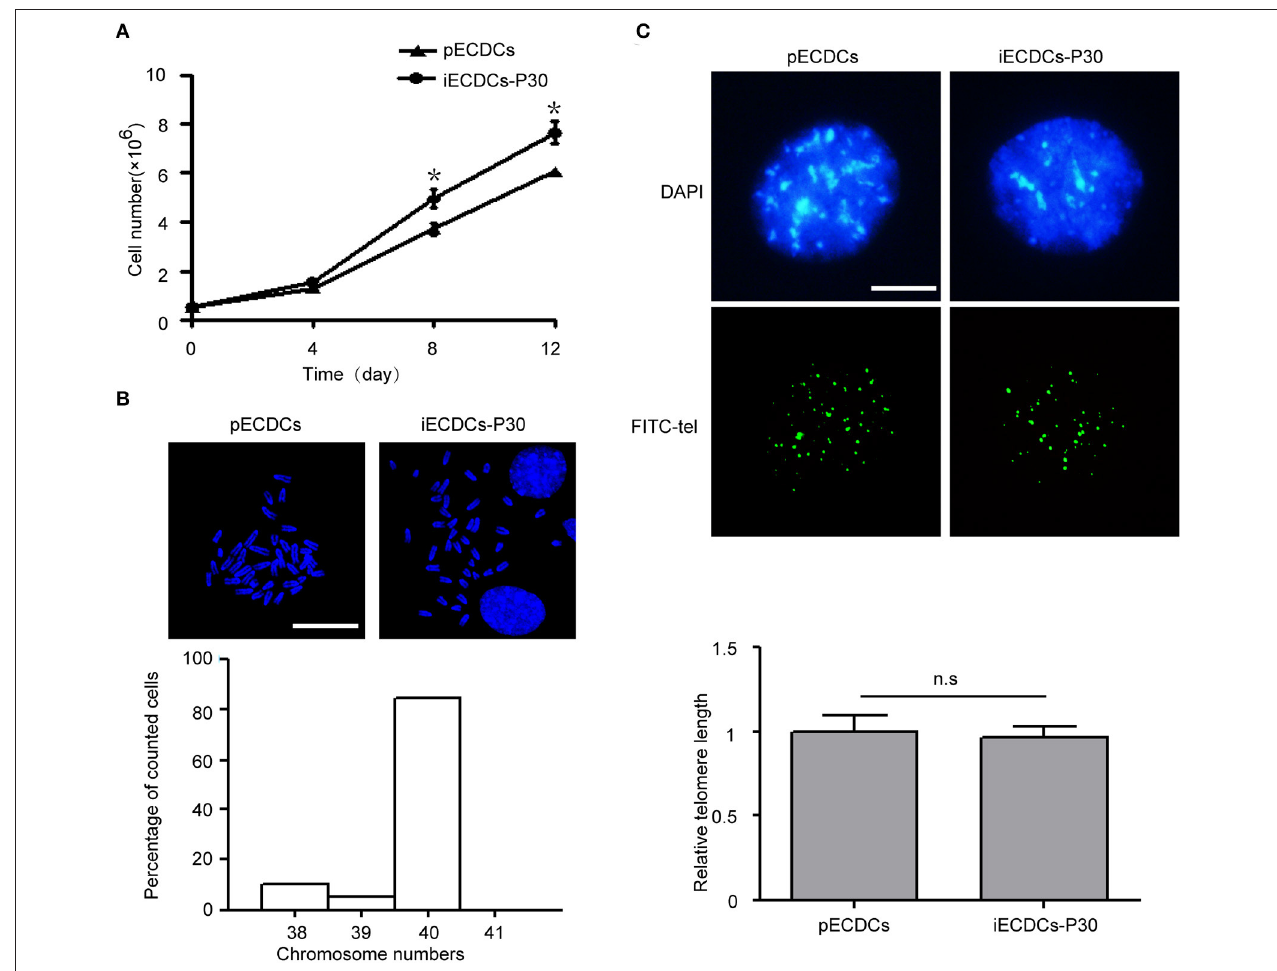
FIGURE 2 | Establishment of mouse immortalized ECDCs (iECDCs). (A) Growth curves of isolated pECDCs and iECDCs at passage 30. Data represent mean ± SEM ( n = 3, * p < 0.05, two-tailed t -test). (B) 4 ′ ,6-diamidino-2-phenylindole (DAPI) staining and quantity statistics of chromosome numbers during mitosis in iECDCs at passage 30 ( n = 25). (C) Telomere Quantitative Fluorescent in situ hybridization (Q-FISH) and quantification of pECDCs and iECDCs at passage 30 ( n = 30, ns means no significant difference, two-tailed t